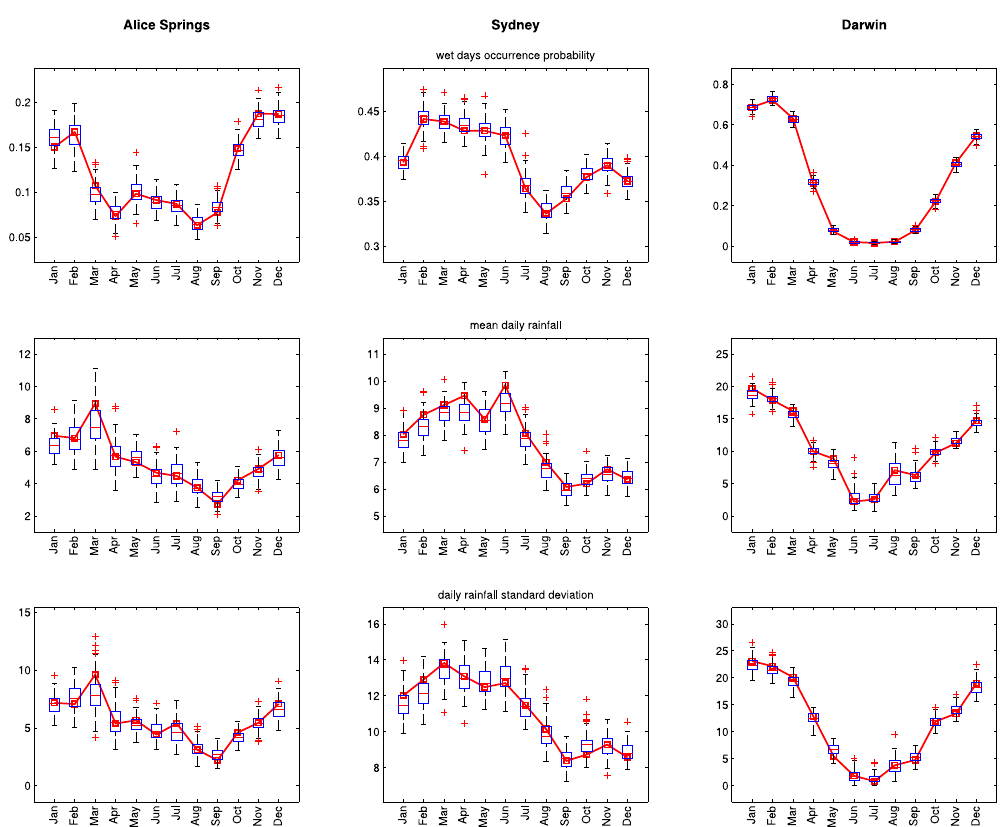
Figure 4. Box plots of the average wet-day probability, mean daily rainfall amount (mm) and its standard deviation per month. The solid line indicates the Fig. 4. Box-plots of the average wet days probability, mean daily rainfall amount [ mm ] and its standard deviation per month. The solid line indicates the reference.